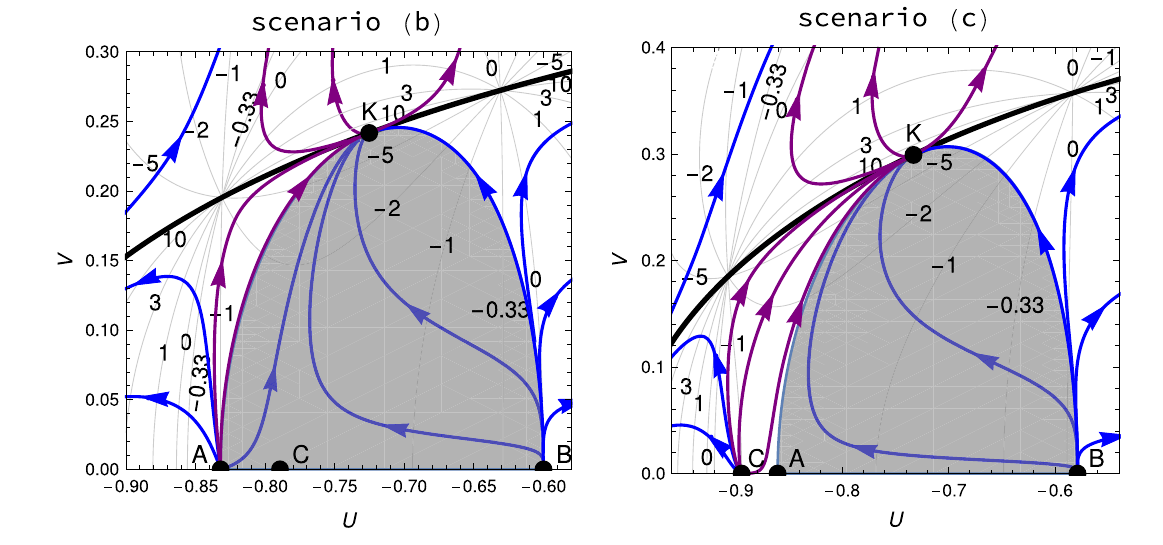
Fig. 13 The fragment of phase portraits of system (25) on the Poincaré Purple arrows denote orbits corresponding to the evolution from the w φ = − 1 equilibria A (left) or C (right) to the w φ = − 1 equilibrium sphere for the generic scenario ( b ) (on the left) and the generic scenario E , while the blue arrows denote other orbits. Light grey contours cor- ( c ) (on the right). Values of parameters are ξ = 3 , n = − 1, ε = − 1 16 respond to values of the equation of state parameter w φ . The shaded for the ( b ) scenario, and ξ = 1 , n = − 2, ε = − 1 for the ( c ) scenario. 5 region is